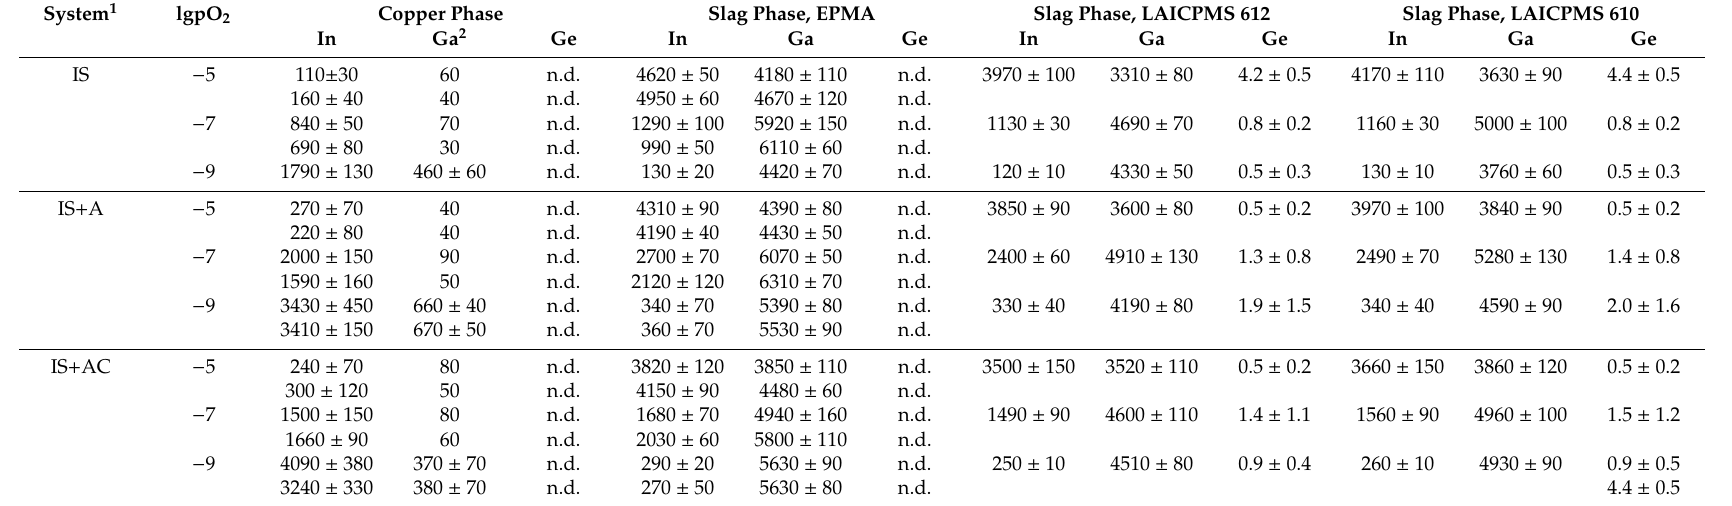
Table 3. High-tech metal results in ppmw with both analytical techniques and